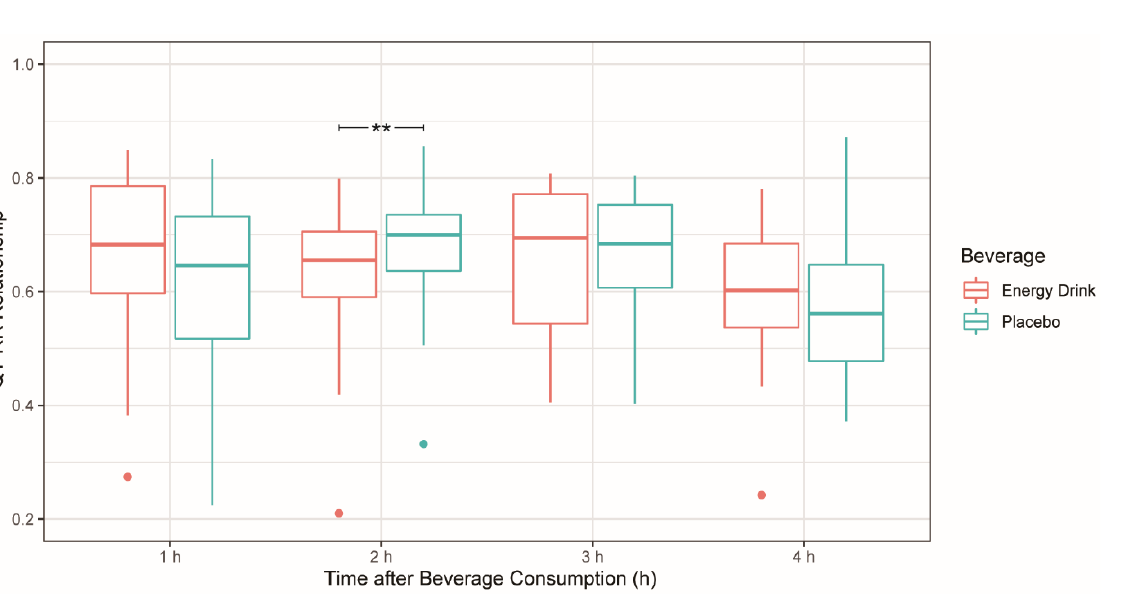
Figure 3. QT – RR relationship after energy drink and placebo consumption at different time periods. ** p < 0.01. ** p <